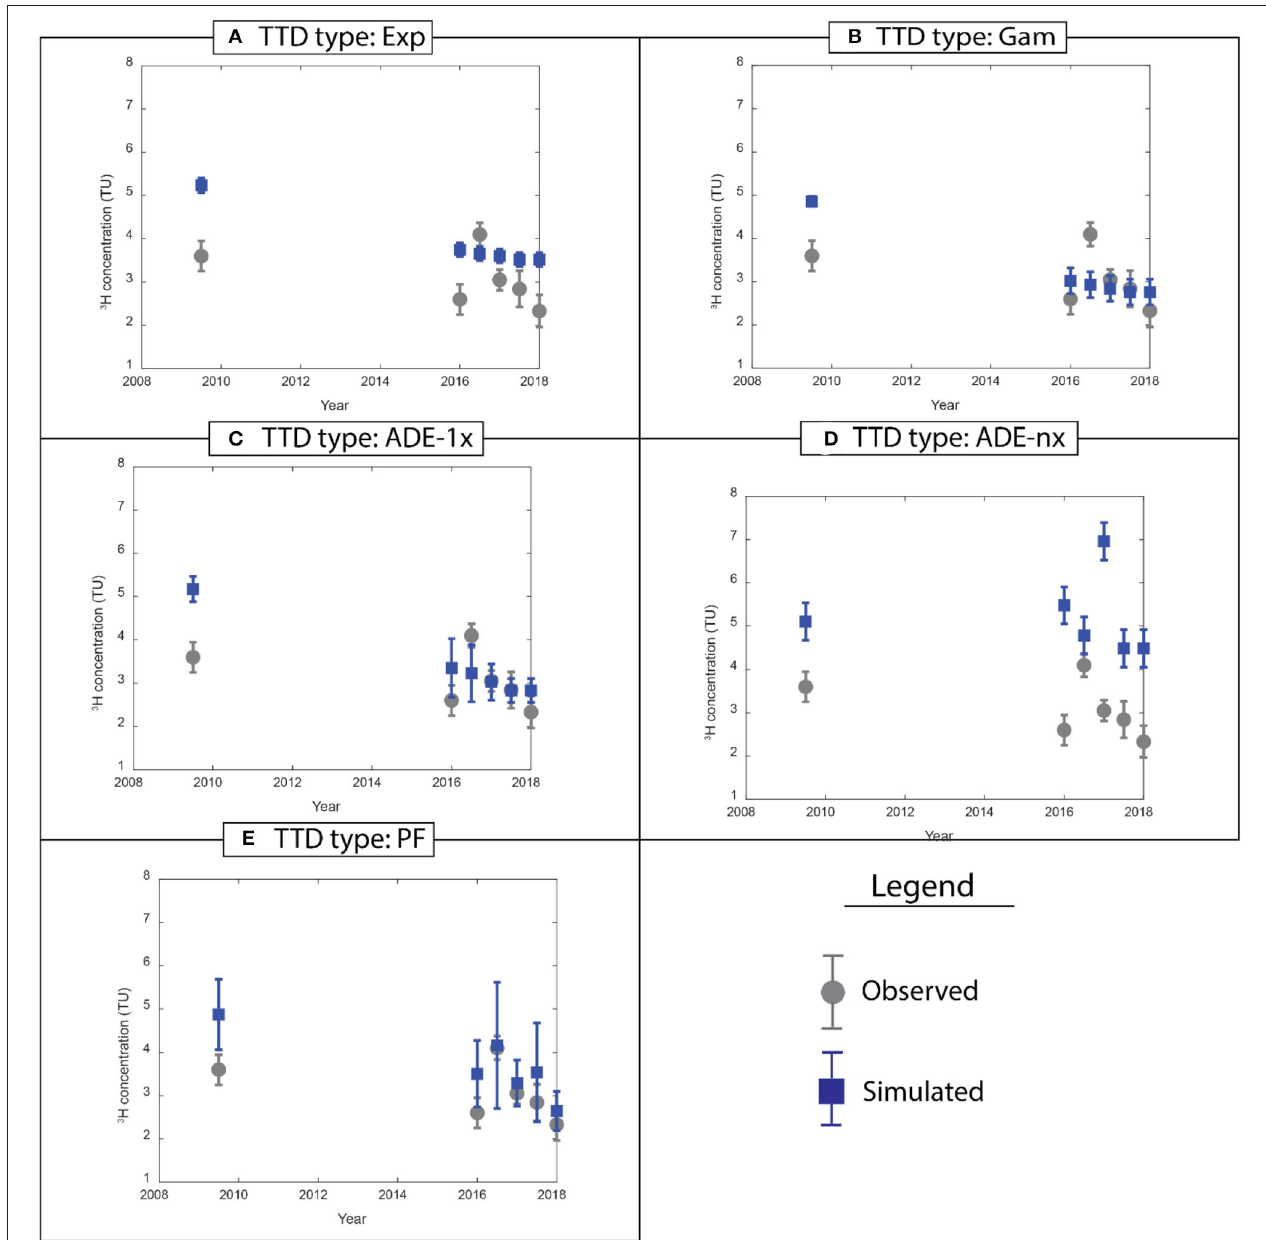
FIGURE 5 | Observed (gray points) and modeled (blue points) 3 H concentrations in deep groundwater for (A) Exp, (B) Gam, (C) ADE-1x, (D) ADE-nx, and (E) PF TTD types. Error bars for the modeled concentrations represent one standard deviation of all the modeled concentrations for the first model run (i.e., run #1 in Supplementary Table 3 ), based on uncertainty in amount-weighted 3 H concentrations in precipitation and deep groundwater.